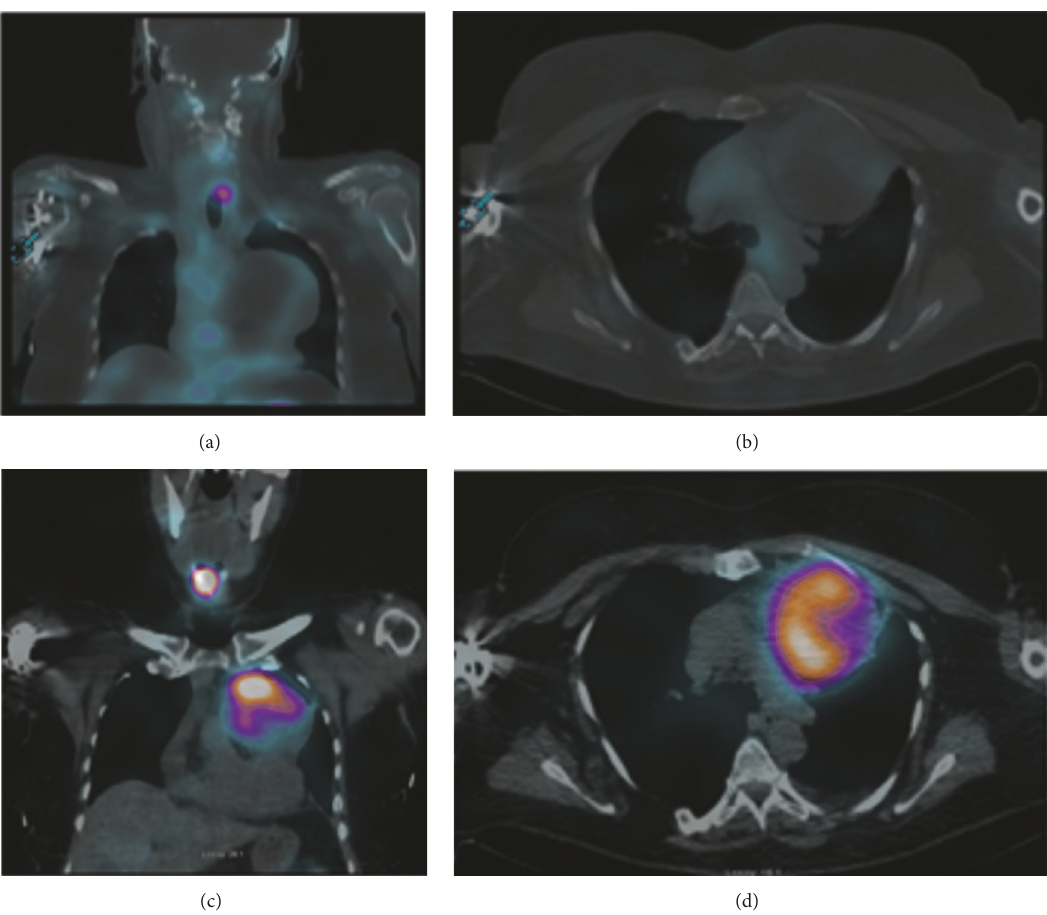
Figure 1: An initial diagnostic SPECT/CT scan was performed 24 hours after administration of 5.3 mCi of Iodine-123. There is uptake in the left, posterior thyroid bed and anteriorly at the level of the hyoid bone. Physiologic uptake was noted in the salivary glands, nasopharyngeal mucosa, and gastrointestinal tract. A large (8cm × 9cm × 8 cm) heterogeneous left anterior mediastinal mass with mixed solid and cystic architecture was noted. This mass did not demonstrate uptake of the Iodine-123 tracer ((a), (b)). Posttreatment SPECT/CT one week later showed uptake of radioactive iodine by the mediastinal mass ((c),